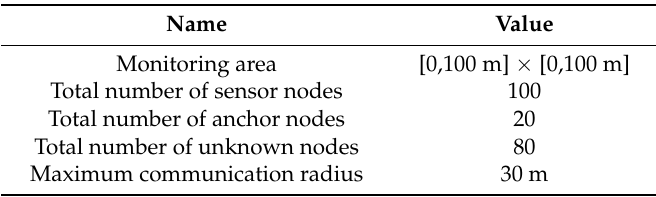
Table 2. Parameter table for influence analysis of ranging error.